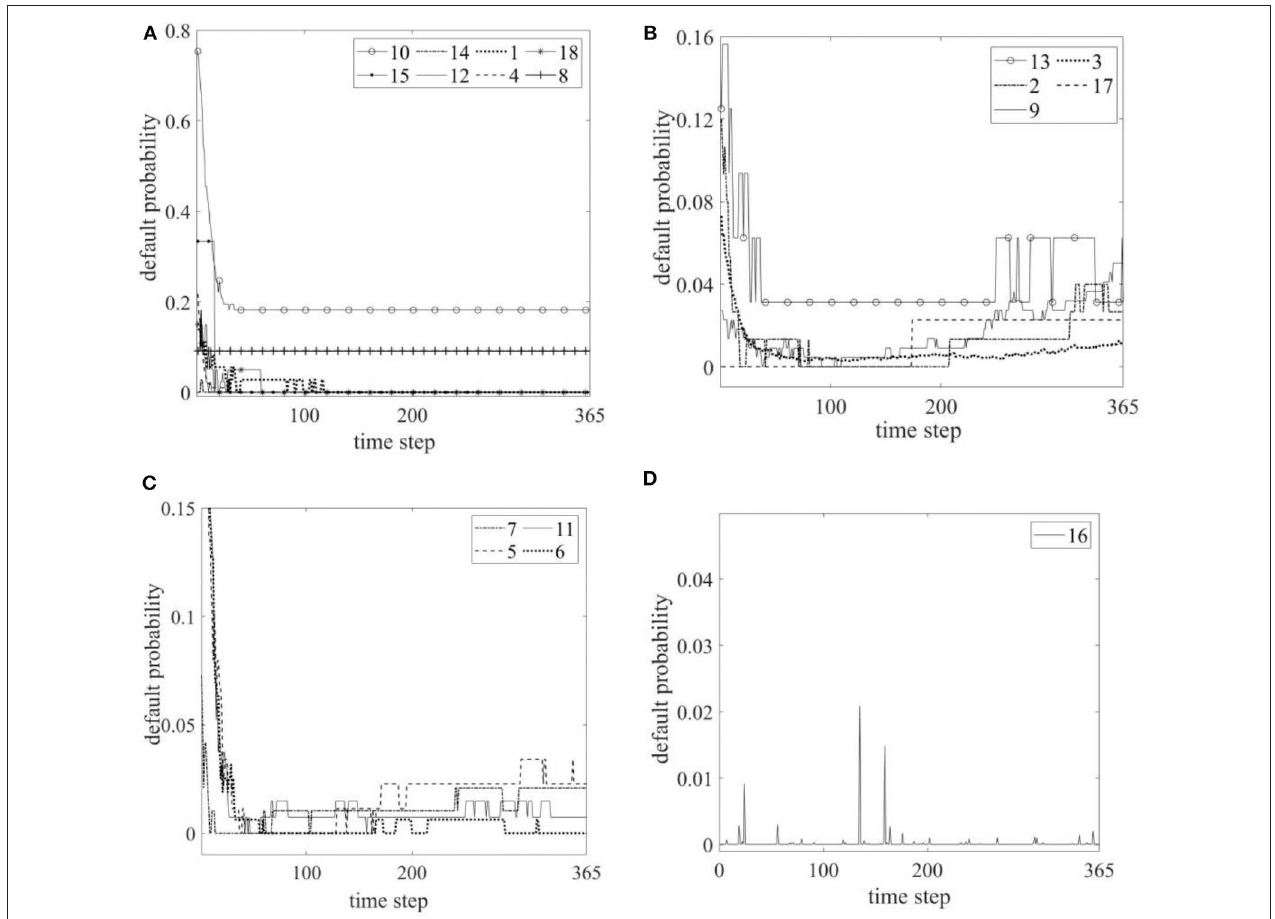
FIGURE 3 | Credit default probability curve of the real industry. (A) Curve of stability after decline. (B) Curve of increasing in fluctuation. (C) Curve of decreasing in fluctuation. (D) Curve of